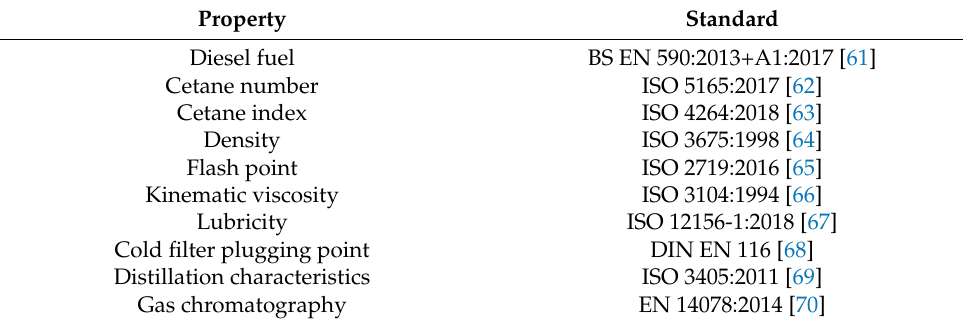
Table 3. Standards for the evaluation of the physicochemical